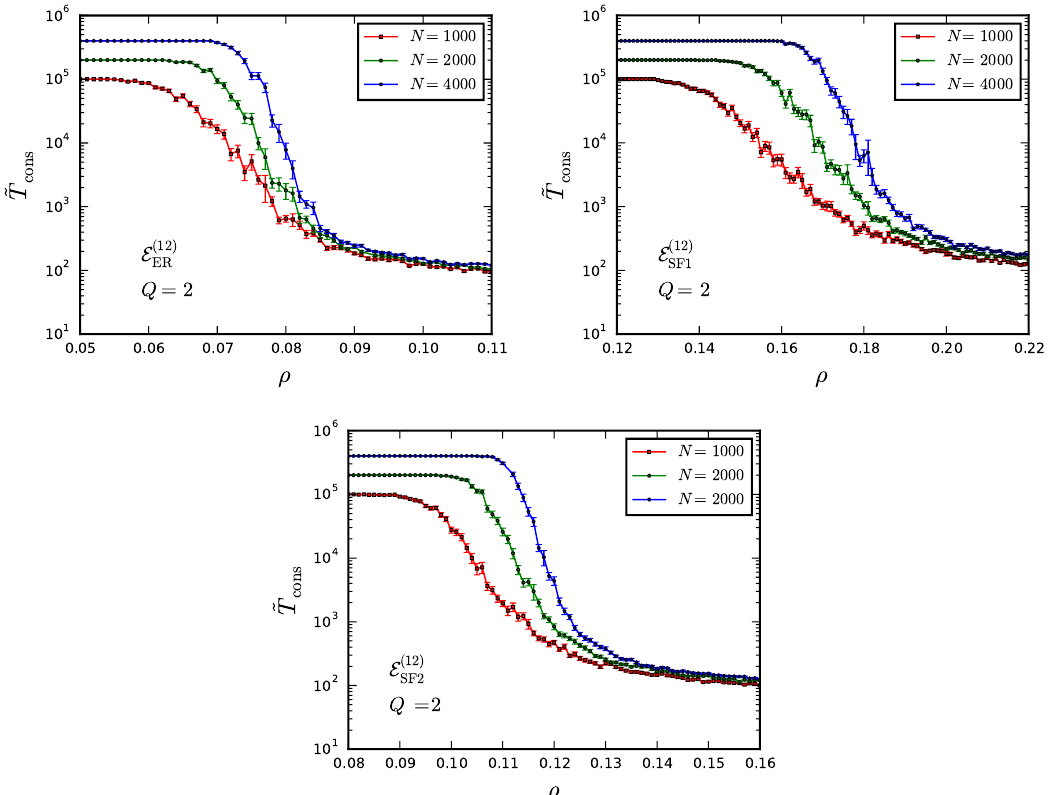
Figure 13. Bounded time to consensus from simulations in M 5